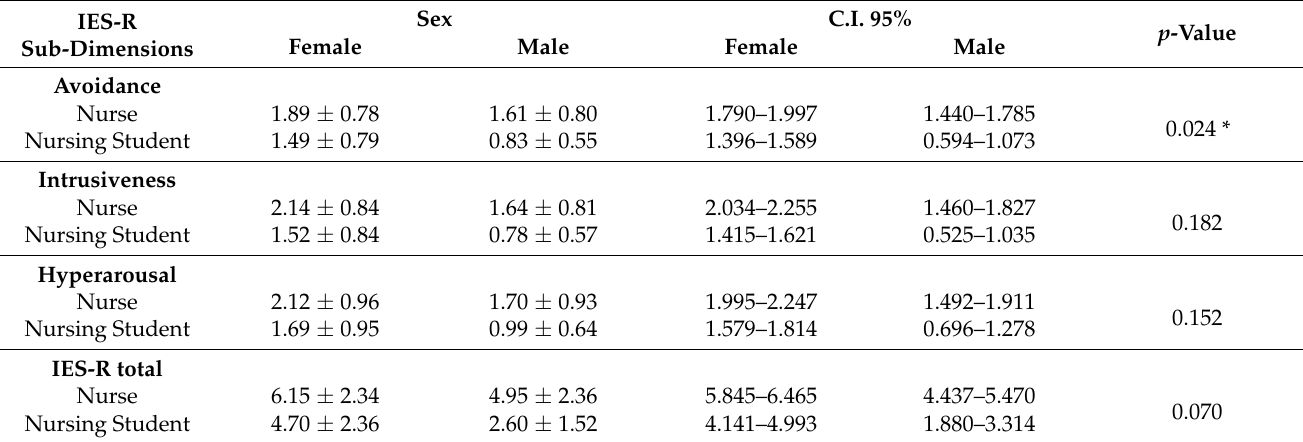
Table 2. IES-R values recorded in Nurses and Nursing Students according to